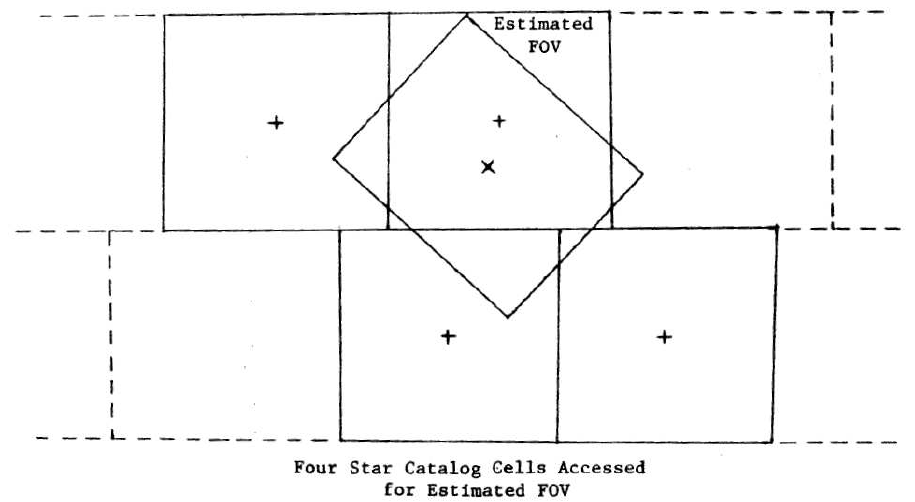
Figure 3. Field-of-view-sized sub-catalogs (reprinted from